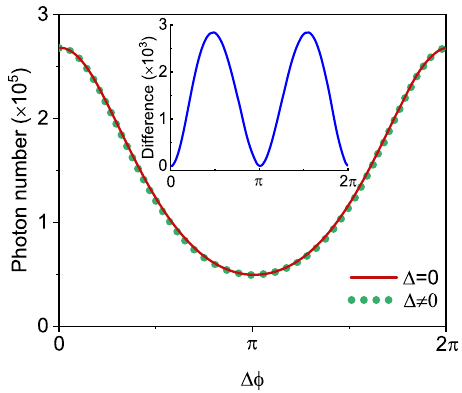
Fig. 6 Photon number at steady state as a function of the phase shift. Here, g = 1.99 × 10 5 s − 1 , Ω = 4.30 × 10 7 s − 1 , and N eff = 5.71 × 10 9 . The red line and the green dotted line represent the photon number when Δ = 0 and Δ ≠ 0, respectively. The inset shows the difference between the photon numbers when Δ = 0 and Δ ≠ 0.